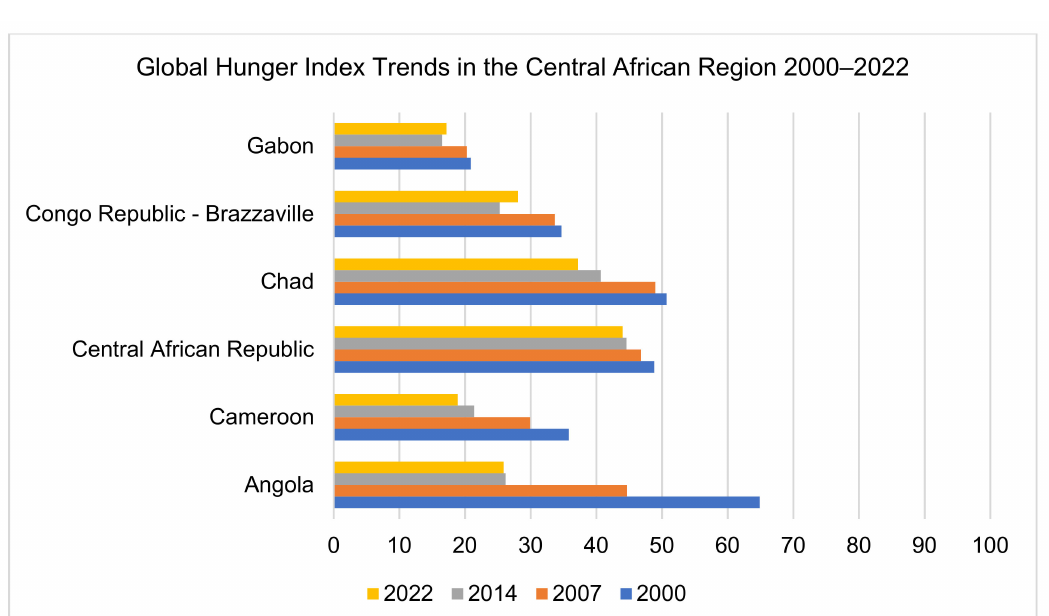
Figure 4. Global hunger index (GHI) trends between 2000 and 2022 across six countries in the Central African